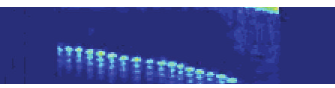
Figure 9: Extracted ROI with improved